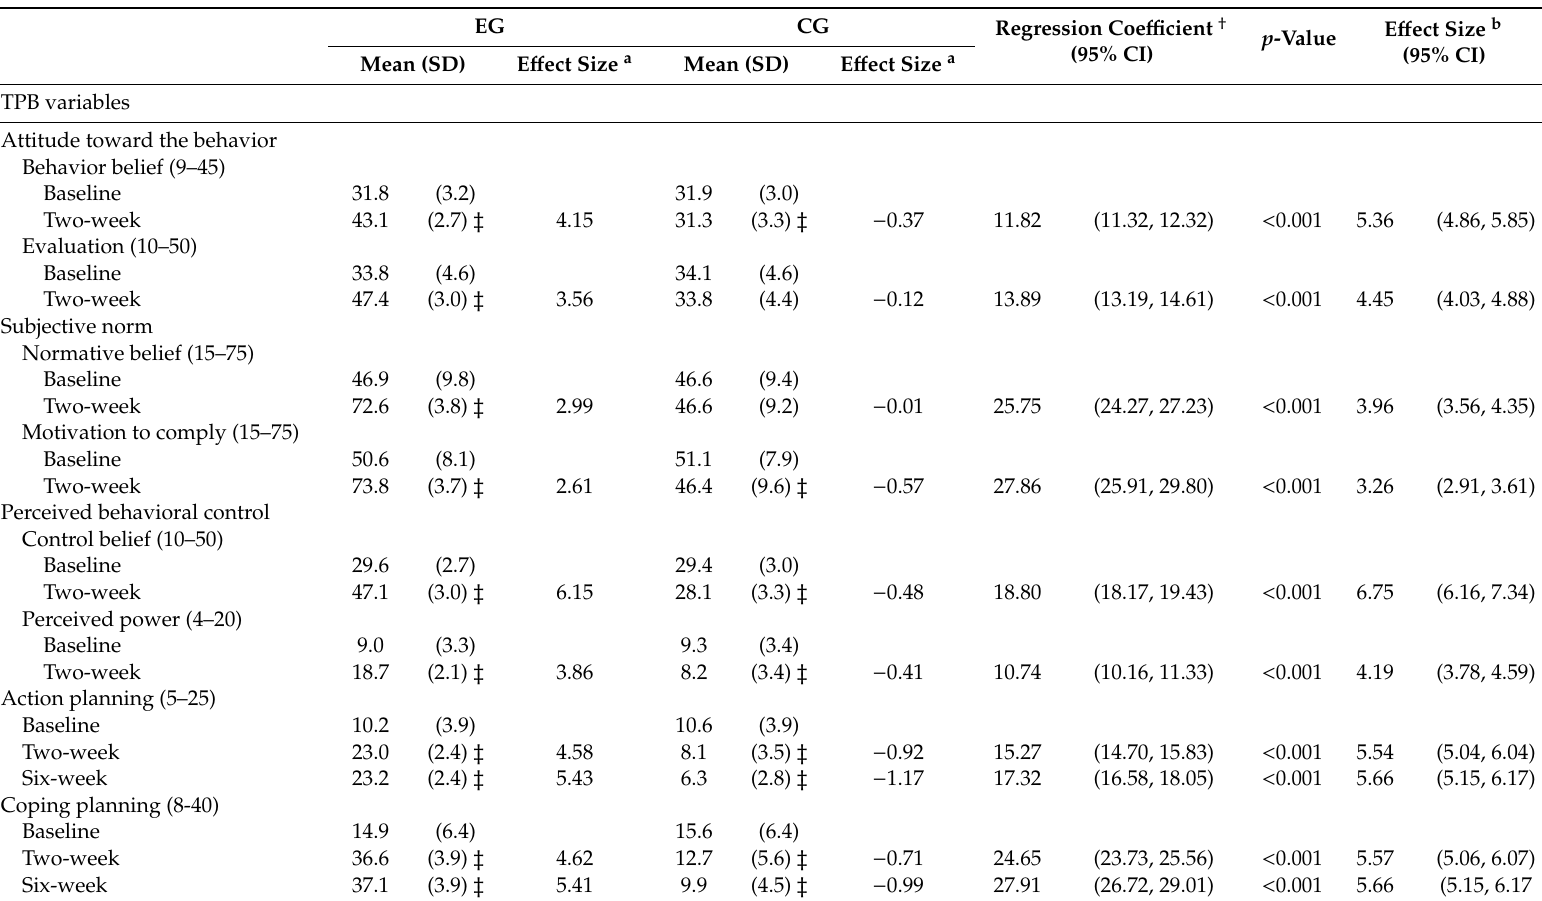
Table 2. Regression-estimated mean di ff erences of theory of planned behavior (TPB) measures and planning variables among PD patients between the